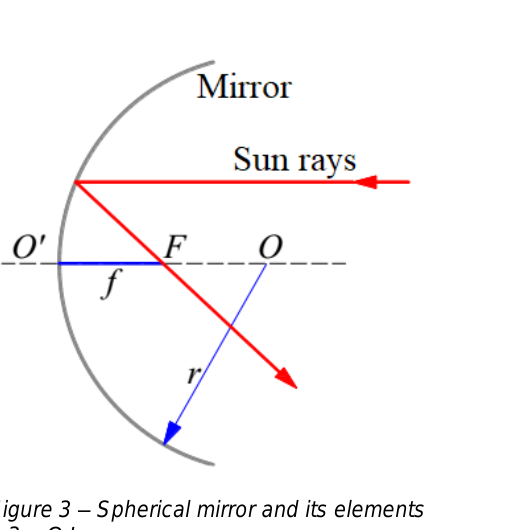
Figure 3 – Spherical mirror and its elements Рис. 3 – Сферическое зеркало и его элементы Слика 3 – Сферно огледало и његови